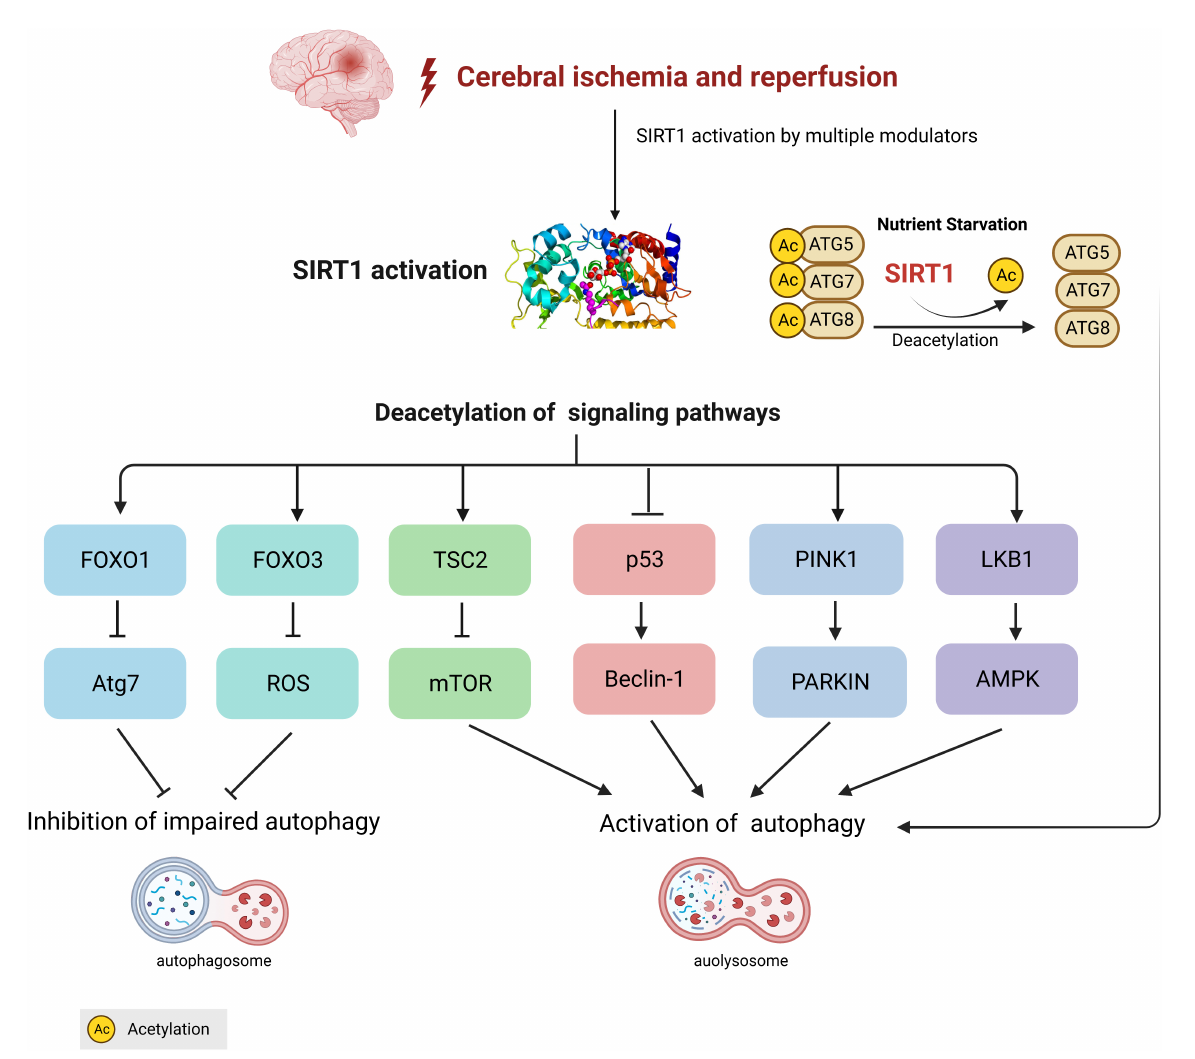
FIGURE1 Crosstalk between silent information regulation protein 1 (SIRT1) and autophagy in cerebral ischemia/reperfusion. During the process of cerebral ischemia, SIRT1-mediated different autophagy signaling pathways are involved in the activation or inhibition of autophagy. Under nutrient starvation conditions, SIRT1 directly deacetylates autophagy-related components, including Atg5, Atg7, and Atg8 (LC3) to form ATG 5-7-8 complex and activates